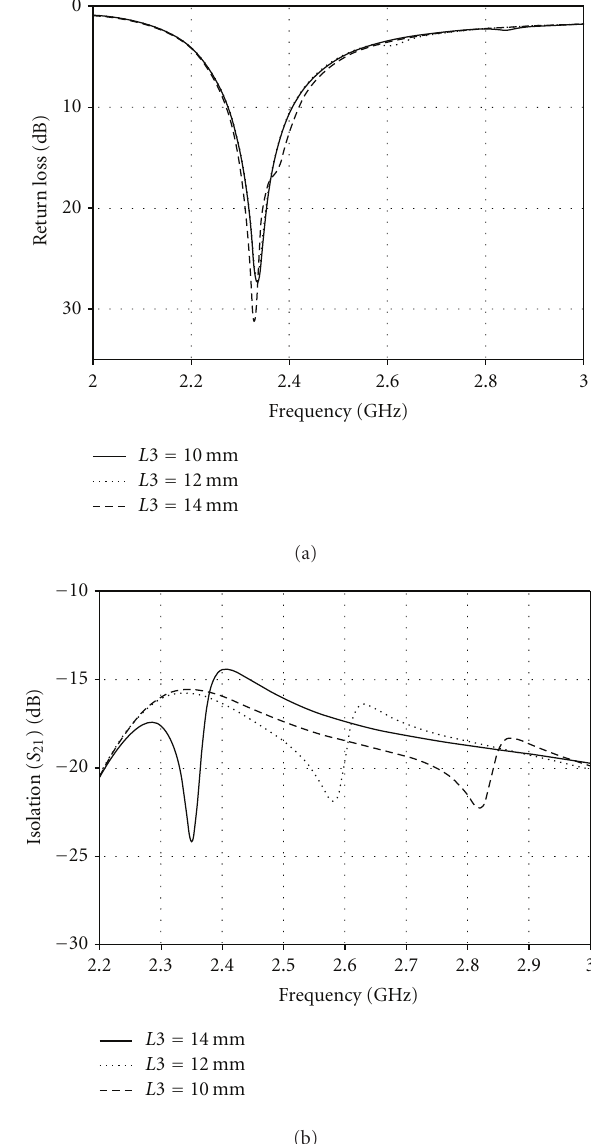
Figure 4: Simulated return loss and isolation characteristics of proposed MIMO antenna with the interdigital SRR: (a) return loss for various L 3, (b) isolation for various L